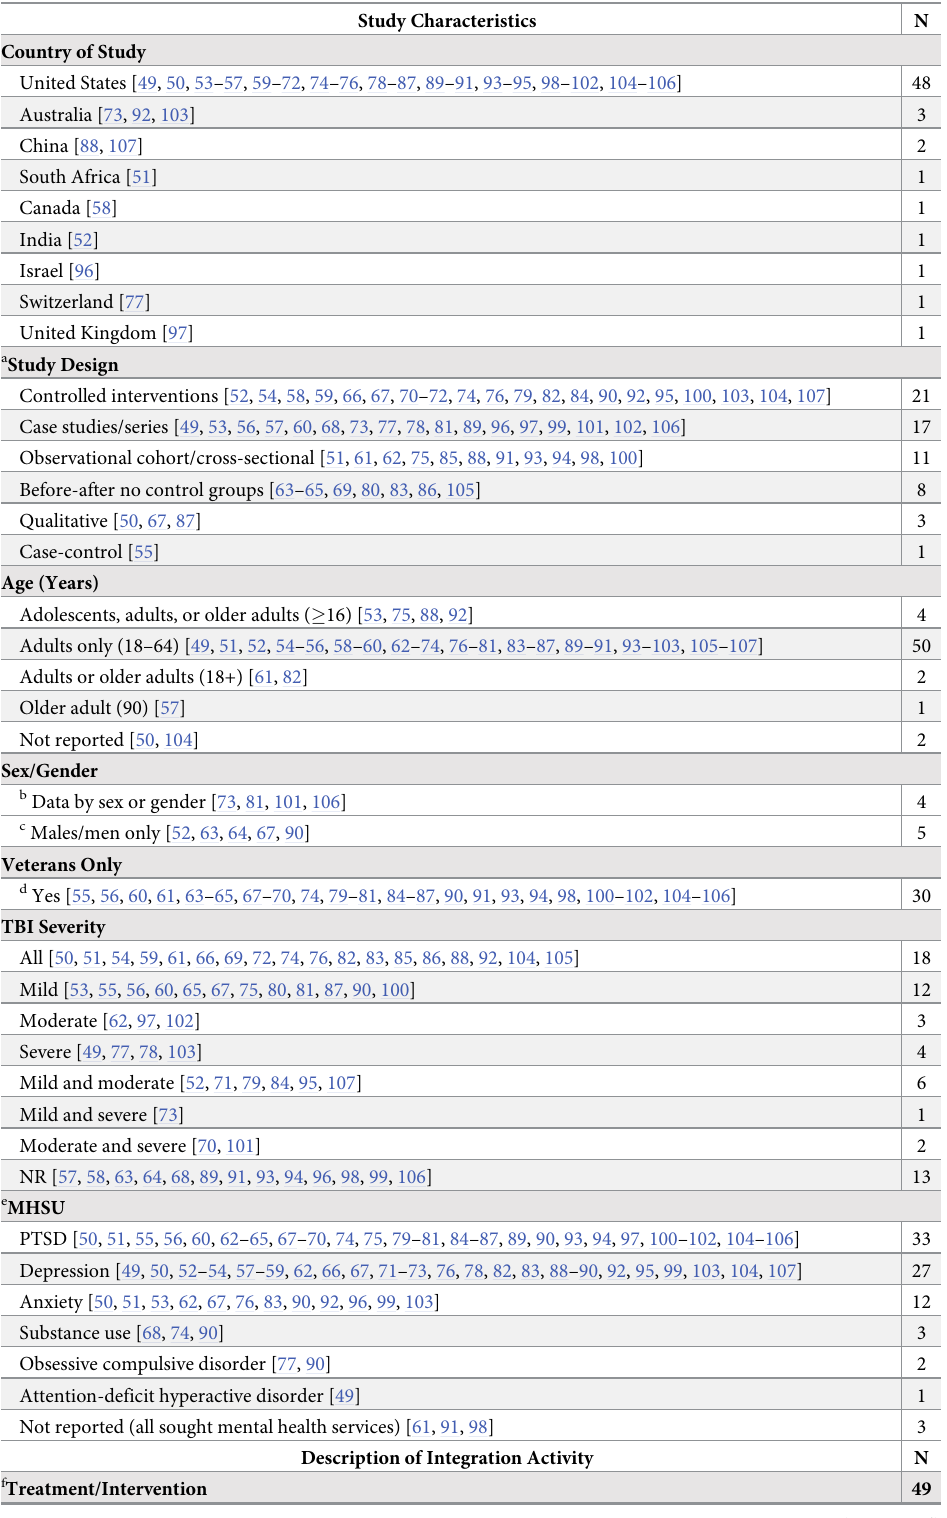
Table 2. Study characteristics and description of integration